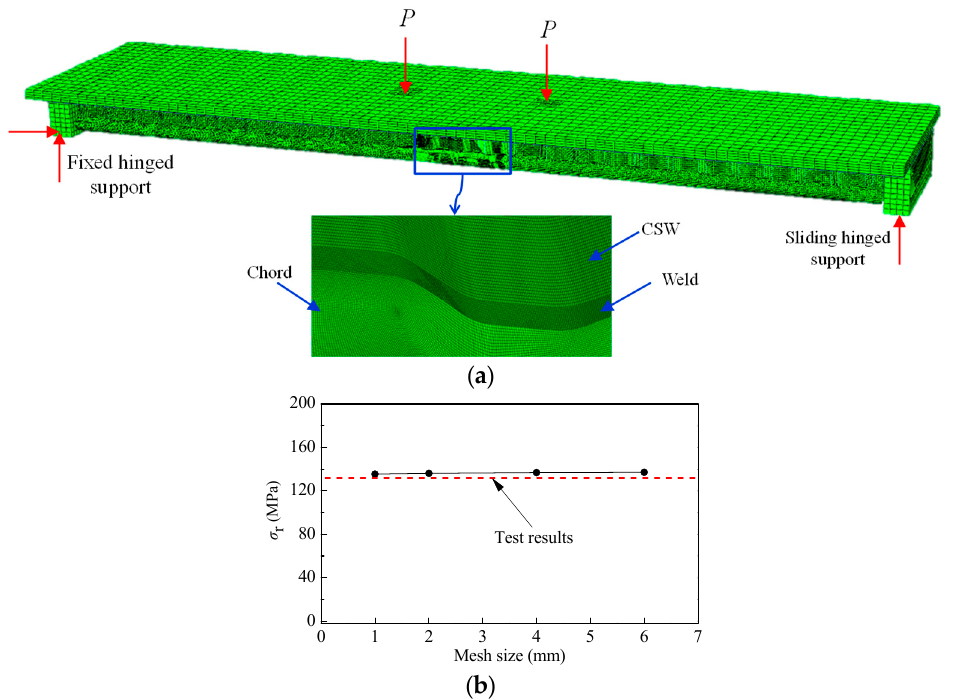
Figure 10. FE model: ( a ) FE mesh; and ( b ) mesh size convergence.